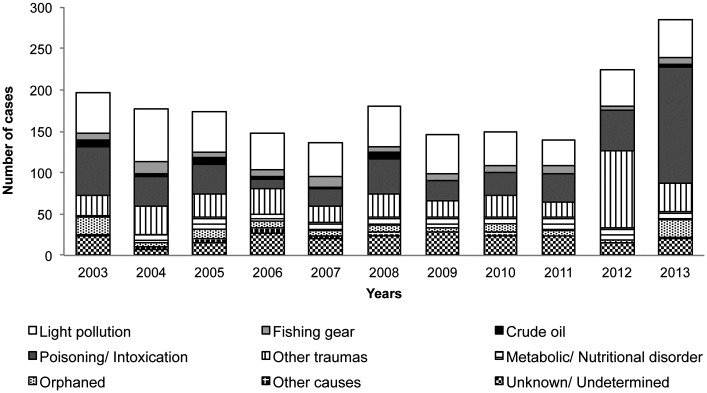
Annual variation in causes of admission of seabirds at the Tafira Wildlife Rehabilitation Center (2003–2013).